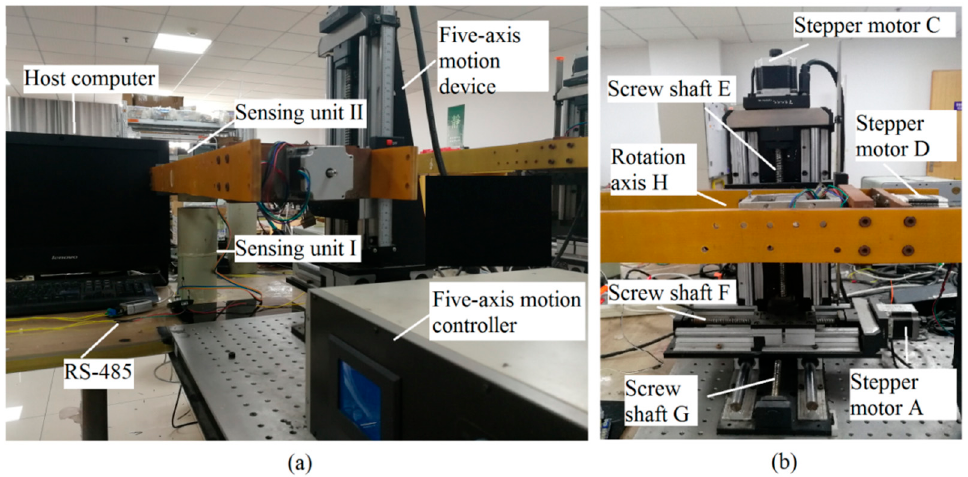
Figure 6. Data acquisition experimental device. ( a ) The system composition of experimental device; ( b ) five-axis motion device.